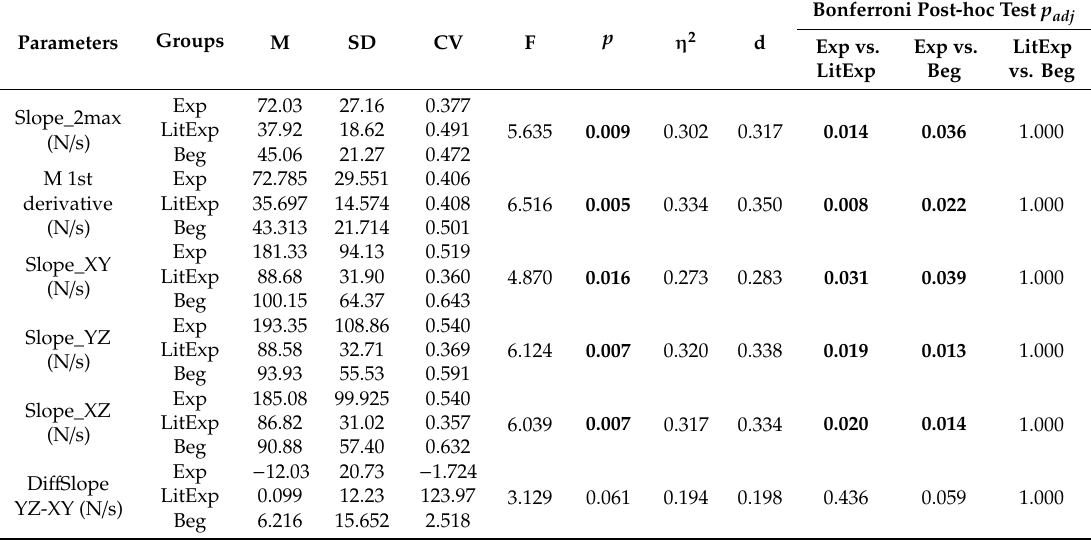
Table 6. Arithmetic means (M), standard deviations (SD), coe ffi cient of variations (CV) and statistical results (F value, significance p , eta square ( η 2 ), e ff ect size d and adjusted p -value (p adj ) using Bonferroni post-hoc test) of the MANOVA of slope parameters in comparing the groups experienced (Exp), little experienced (LitExp) and beginners (Beg).